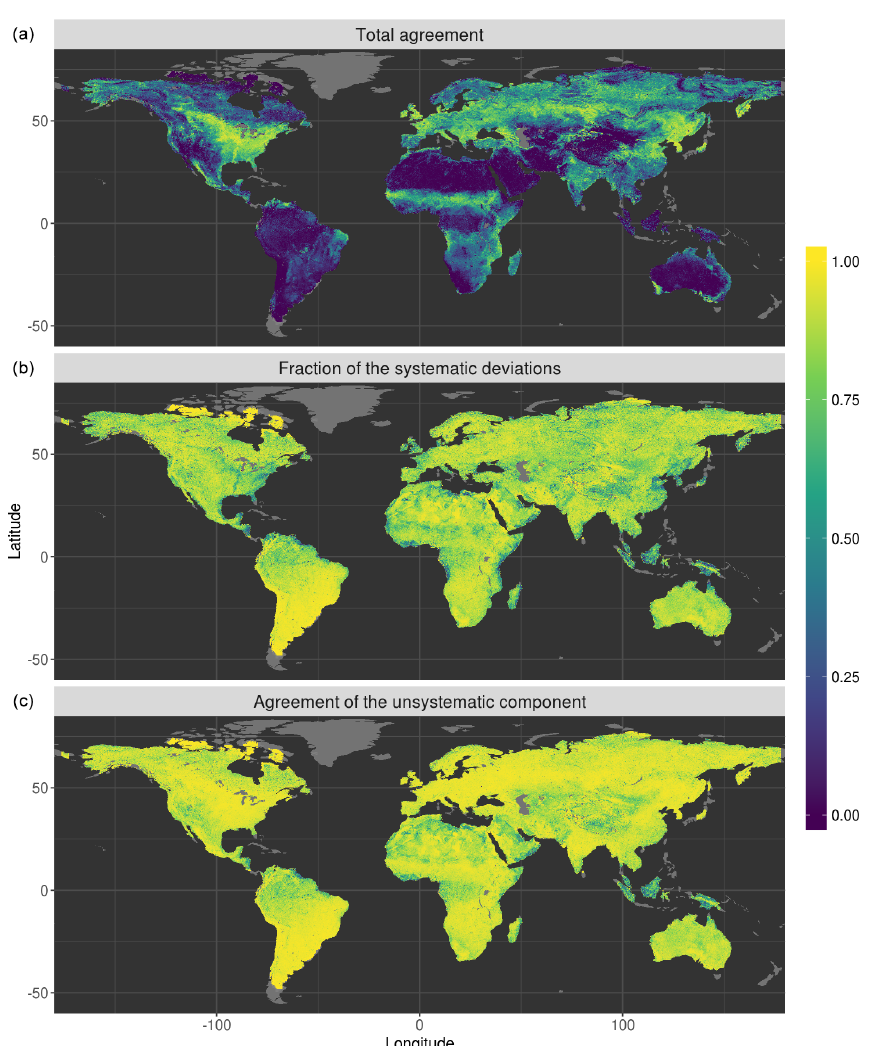
Figure 6. Agreement between the downscaled PK SIF product and TROPOMI SIF retrievals for the period from 16 April to 23 Decem- ber 2018. Panel (a) shows the total agreement using the λ metric, based on all deviations irrespective of whether these are systematic or non-systematic deviations. Panel (b) shows the ratio between systematic and total deviations. Panel (c) shows the agreement based only on the unsystematic component, λ u , in which any disagreement due to a systematic bias is